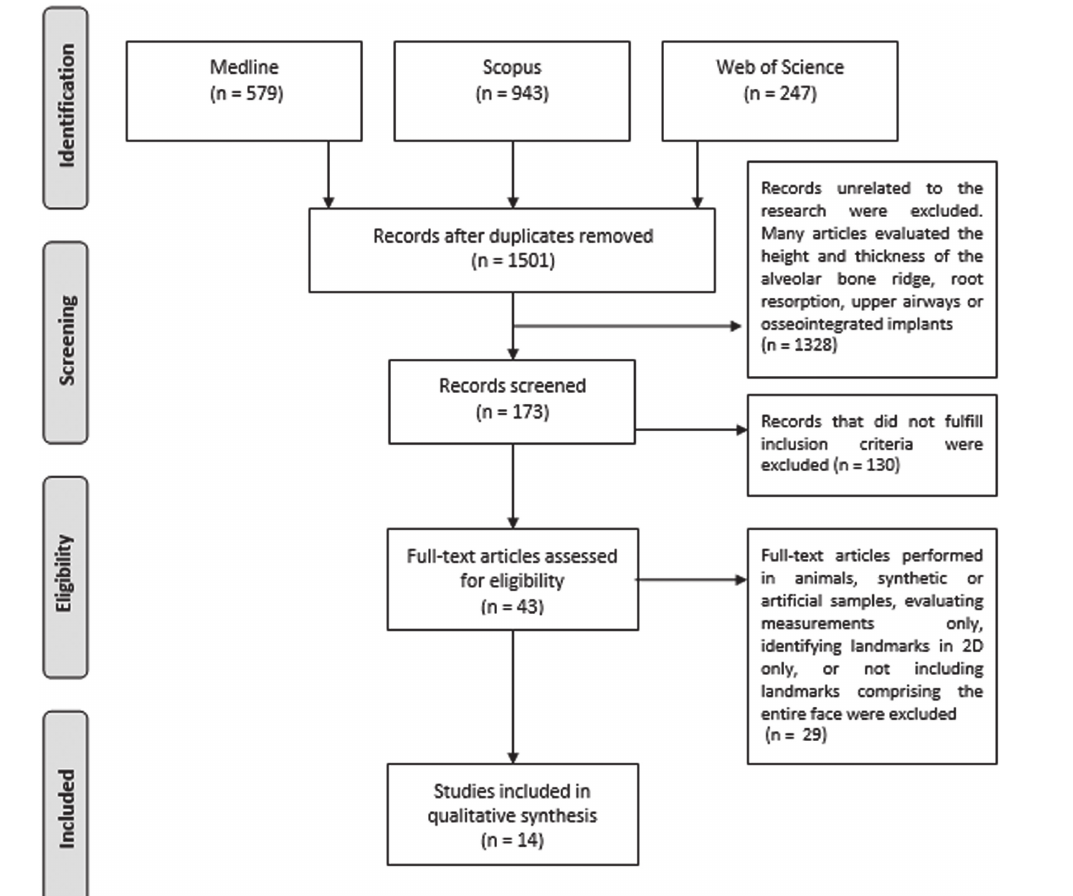
Figure 5- PRISMA flow diagram of the search results from the